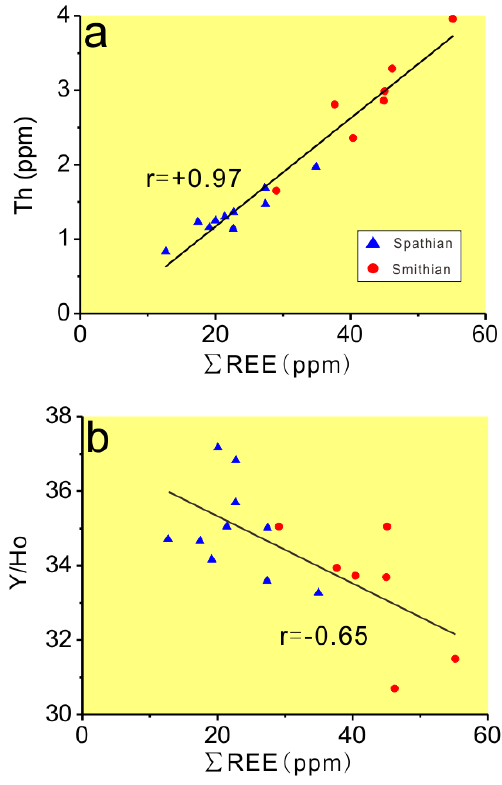
Figure 5. Crossplots of (a) P REE vs. Th and (b) P REE vs. Y/Ho. Strong positive covariation demonstrates derivation of REEs pri- marily from the terrigenous siliciclastic (clay-mineral) fraction of the sediment.